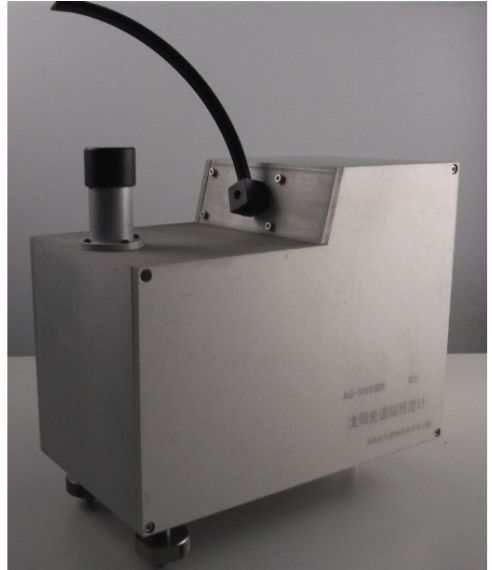
Figure 6. AG-512 SSIR Solar Spectroradiometer.